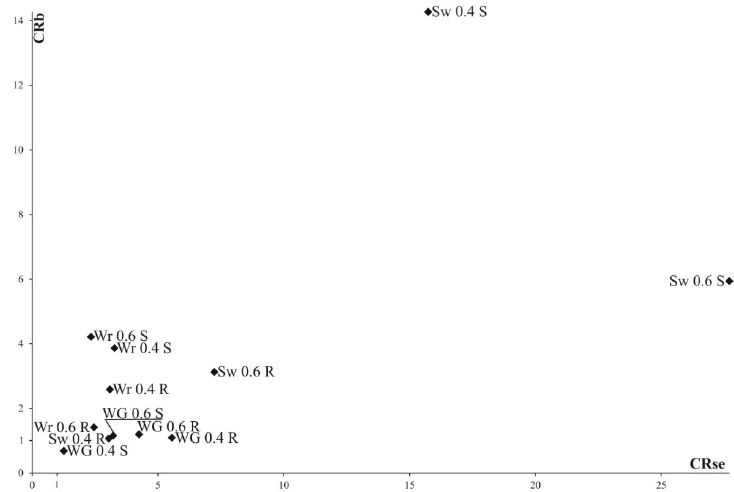
Figure 4. Relationships between relative biomass of plants (CRb) and the relative number of seeds (CRse) for the combinations of sites × winter wheat proportion in the mixture × cornflower biotypes, in 2017–2018. Legend: Sw—Swojczyce, WG—Winna Góra, Wr—Wroc ł aw (sites of experiments); R—cornflower resistant biotype; S—cornflower susceptible biotype. The correlation coefficients were presented as a heatmap for all pairs of observed features (length, yield, TGW, biomass, hydrothermal coefficient, and soil texture). Positive correlations were observed between followed pairs of traits: length-TGW ( r = 0.652). How- ever, negative for: length-K ( r = − 0.636), length-sand ( r = − 0.614), TGW-K ( r = − 0.889), TGW- sand ( r = − 0.872), biomass-K ( r = − 0.578) and biomass-sand ( r = − 0.609) (Figure 5).